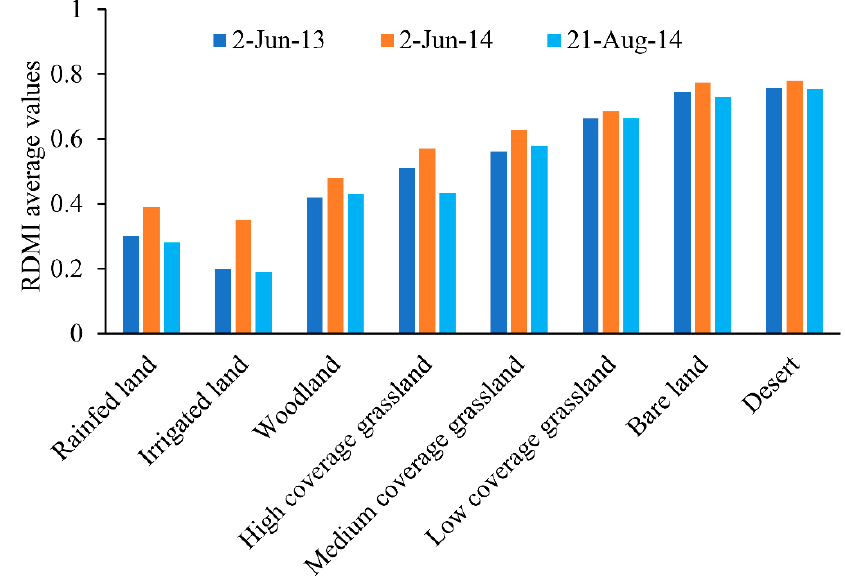
Figure 17. The RDMI average values on different dates for different land cover conditions in Xinjiang.